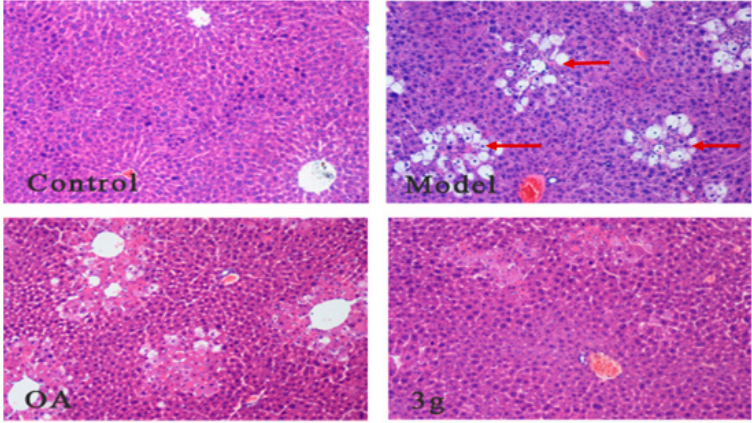
Figure 6. Morphological observation under an optical microscope (×100) by HE staining.